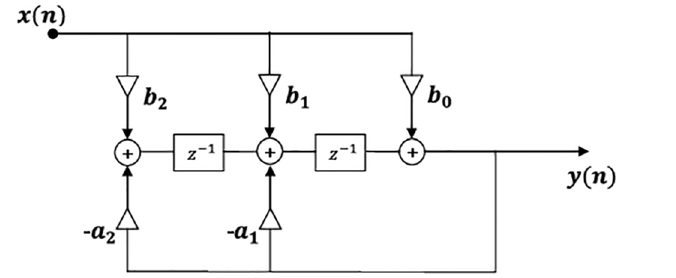
Fig 8. Second order IIR filter.